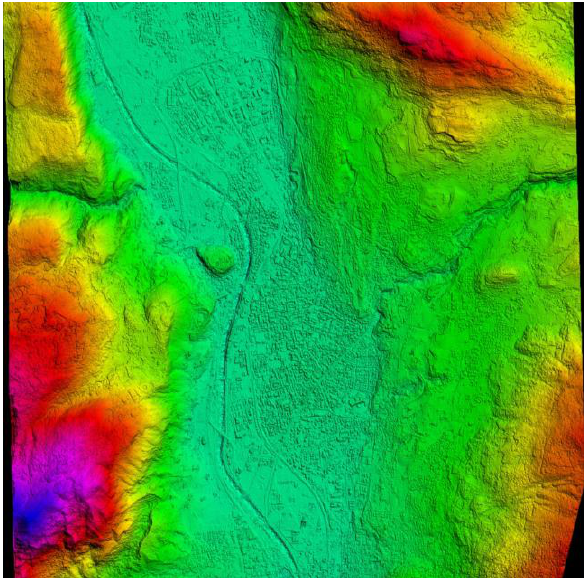
Fig. 5. DSM from the Pleiades triplet visualized in colour- shaded